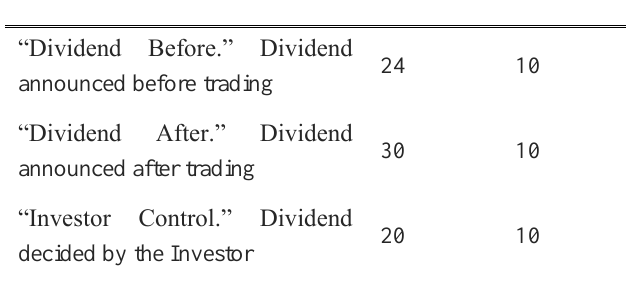
Table VII. Experiment